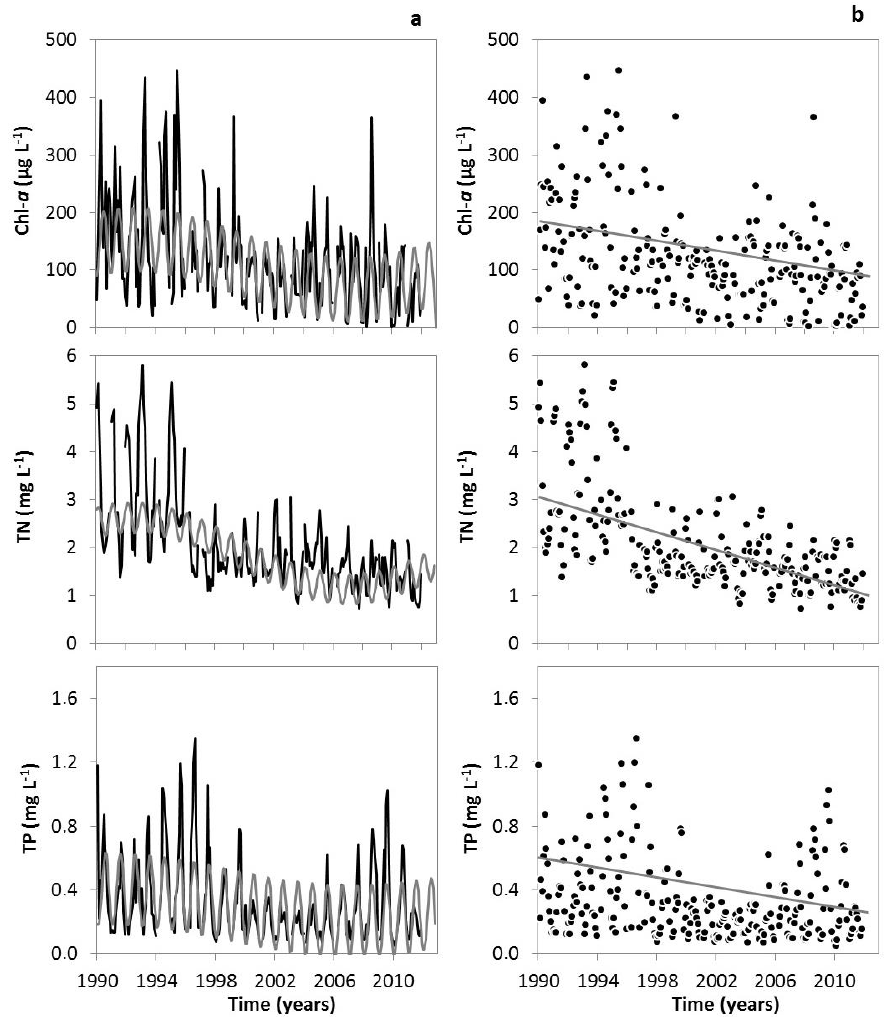
Figure 8. Temporal variations in Chl- a , TN and TP concentrations in Lake Søbygaard region during the 23 years of study (1990–2012): Sinusoidal fit (grey) ( a ) and GLM ( b ) regression lines are shown. Table 3. Multiple GLMMs based on Markov chain Monte Carlo method showing the predictors for chlorophyll- a concentrations (Chl- a ) during the entire study period and the spring–summer period. The mean of the posterior distribution (post.mean), lower and upper 95% credible interval (l-95% CI and u-95% CI), the MCMC p-value (p MCMC ) and deviance information criterion (DIC) are reported.